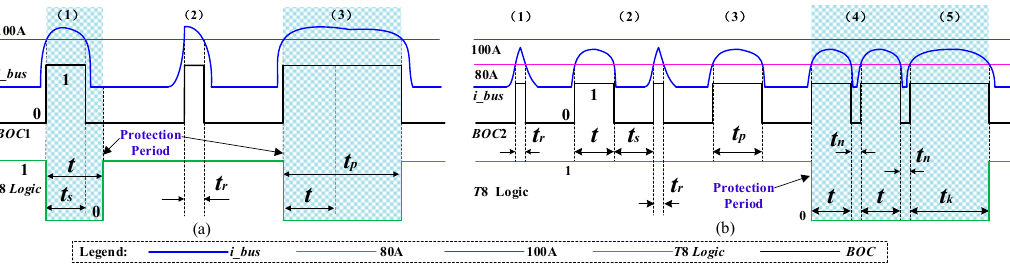
Figure 8. Bus over-current protection logic. ( a ) Transient protection; ( b ) locked protection.